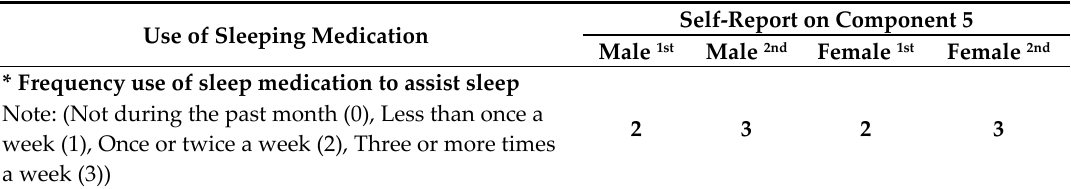
Table 6. Component 6 of the PSQI on 4 the flight attendants.